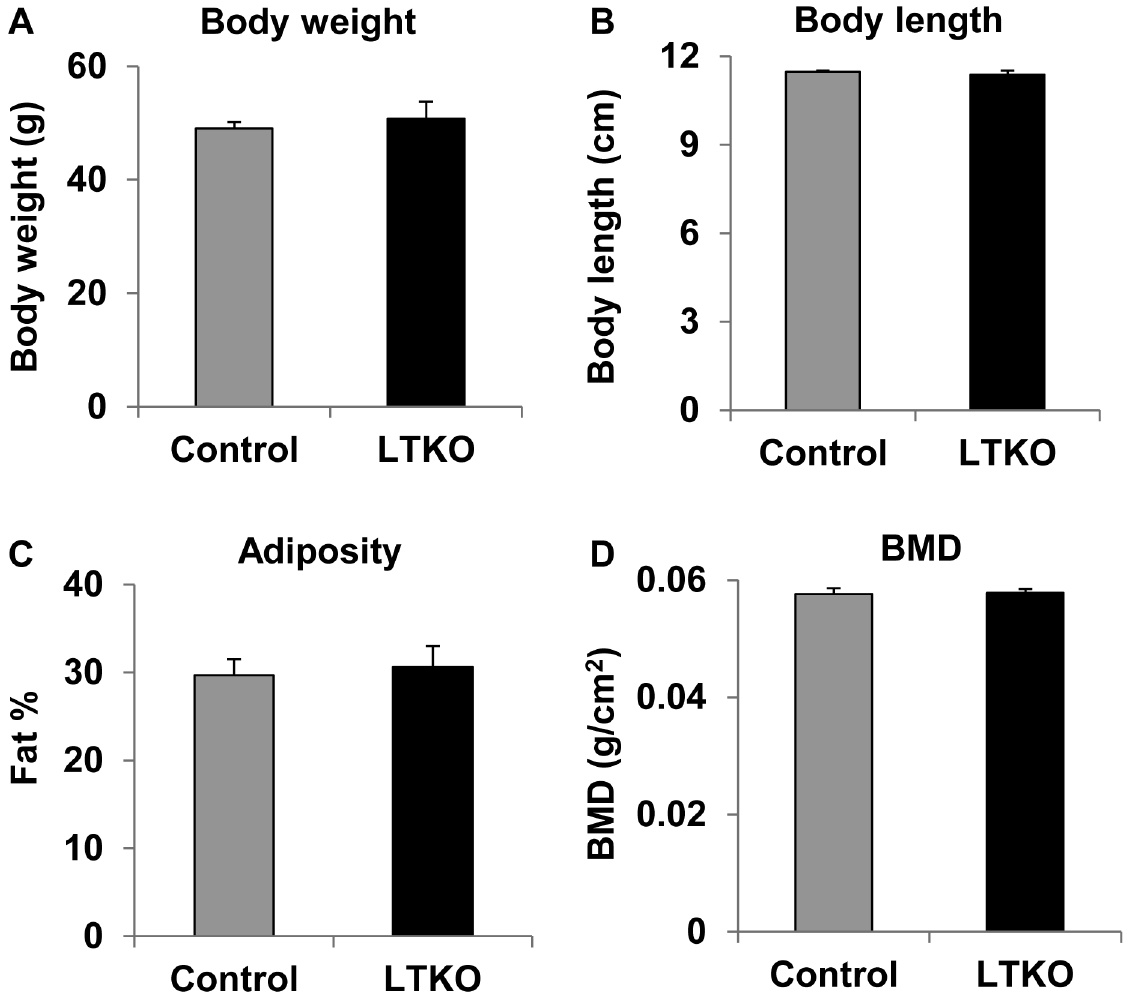
Figure 3. Body composition of LTKO mice fed a high-fat diet. (A, B) Body weight and length measurements of control and LTKO mice (n=6) after a high-fat diet (HFD) treatment for 5 months, respectively. (C, D) Body fat and bone mineral density (BMD) analyses of the above HFD treated mice by DEXA, respectively. Data represent mean ± SEM.